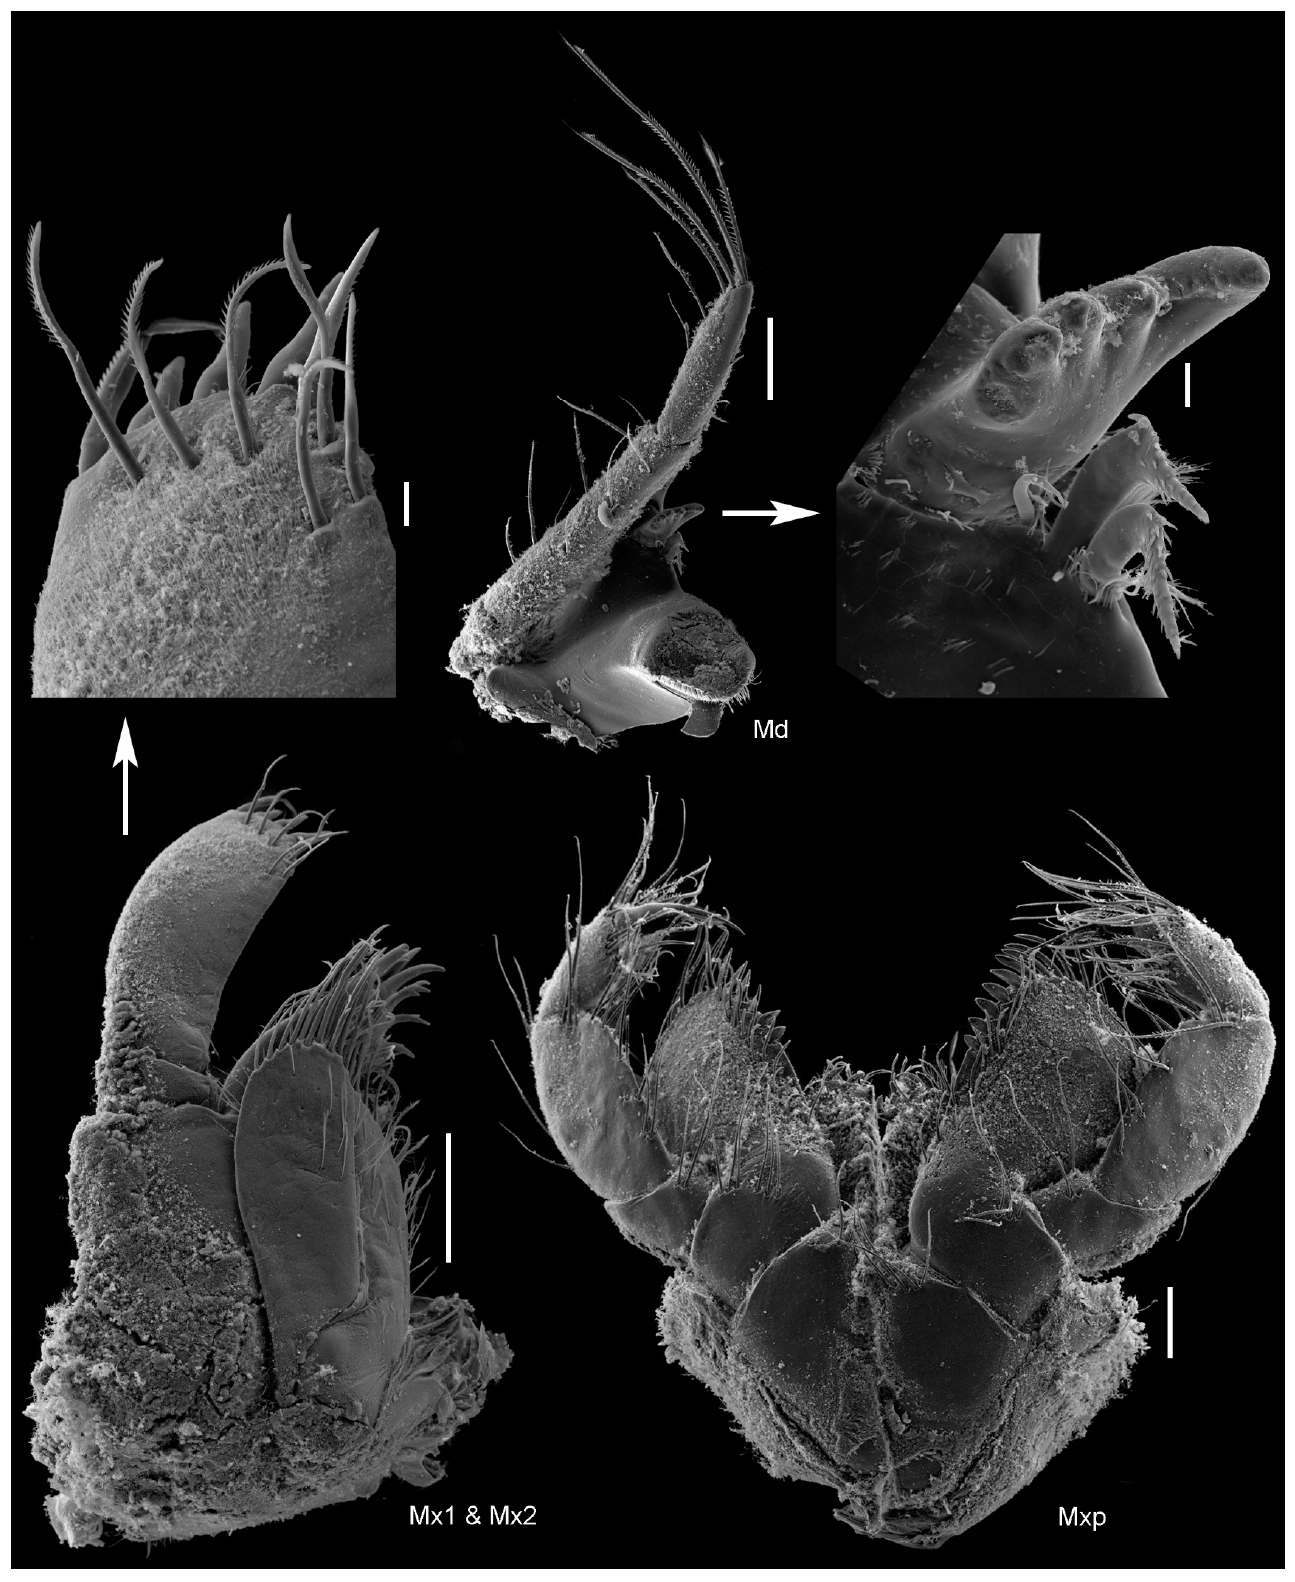
Figure 8. Unciola conchicola sp. nov. SEM image, paratype male, 7 mm, ZMHK-56724, South Island, Iceland Basin, 1921 m. Scales: 0.1 mm, details of terminal end of maxillar plate and mandibular incisor 10 µm.